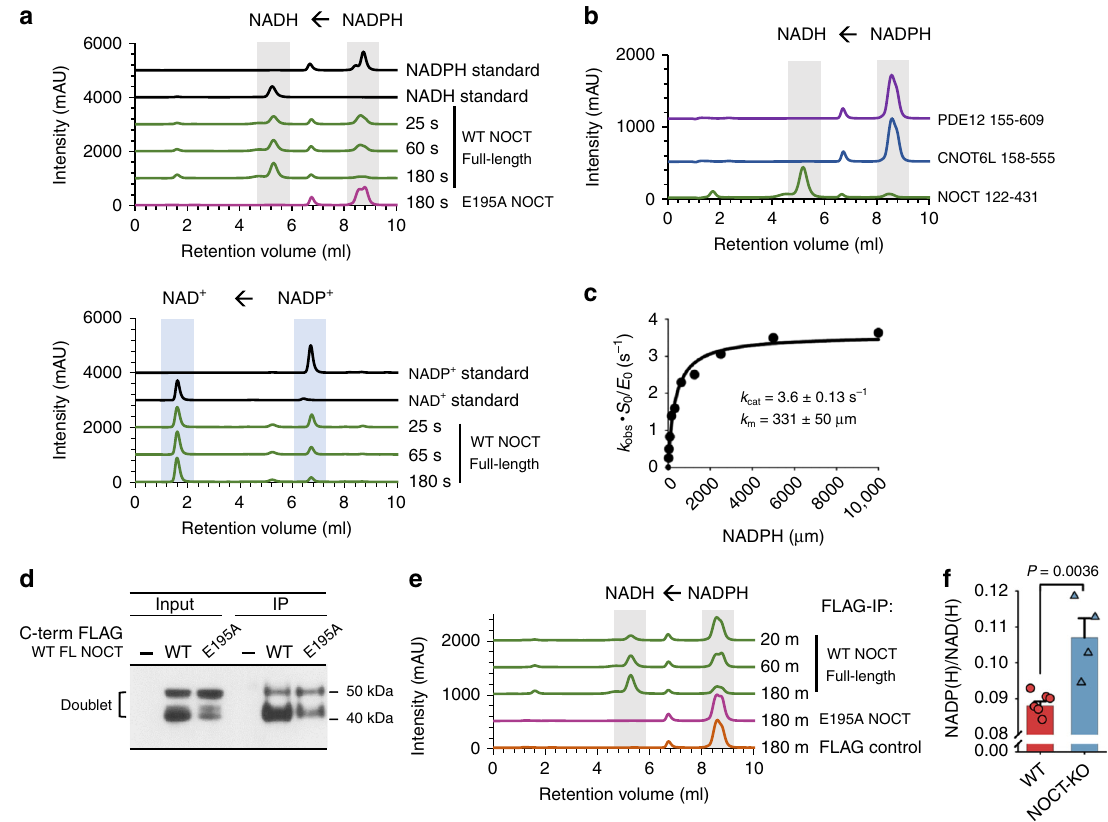
Fig. 2 NADP(H) cleavage characterization. a Time course cleavage of pure NADPH (1 mM) and NADP + (1 mM) by puri fi ed human full-length NOCT (0.5 μ M) at 22 °C, monitored by ion-exchange chromatography (IEC). b 60-min NADPH incubation with the catalytic domains of PDE12, CNOT6L, and NOCT as in a . c Measurement of kinetic parameters for the catalytic domain of human NOCT (4.8 μ M). d Western blot analysis of full-length human FLAG-NOCT (C-terminal tag) expressed in A549 cells for 18 h. e NADPH (1 mM) cleavage by FLAG-NOCT puri fi ed from human cells. f Nicotinamide metabolite composition in WT and NOCT − / − cells (Supplementary Data 2). Six replicates from three WT samples are compared against four replicates from two independently generated NOCT − / − clones. Error bars are standard error (S.E.). Source data are provided as a Source Data fi date, MESH1 (PDB ID 5VXA) 15 . In MESH1 nucleobases rather